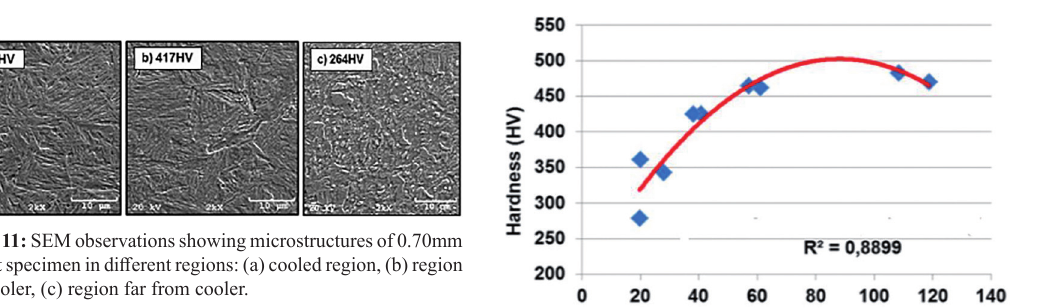
Figure 10: Hardness profile along the specimens for different gaps.